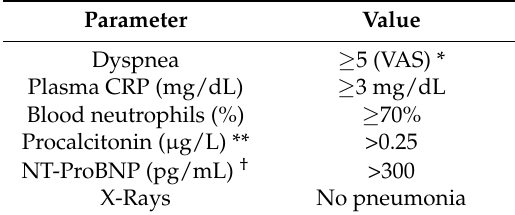
Table 3. A new proposal towards a more precise definition of